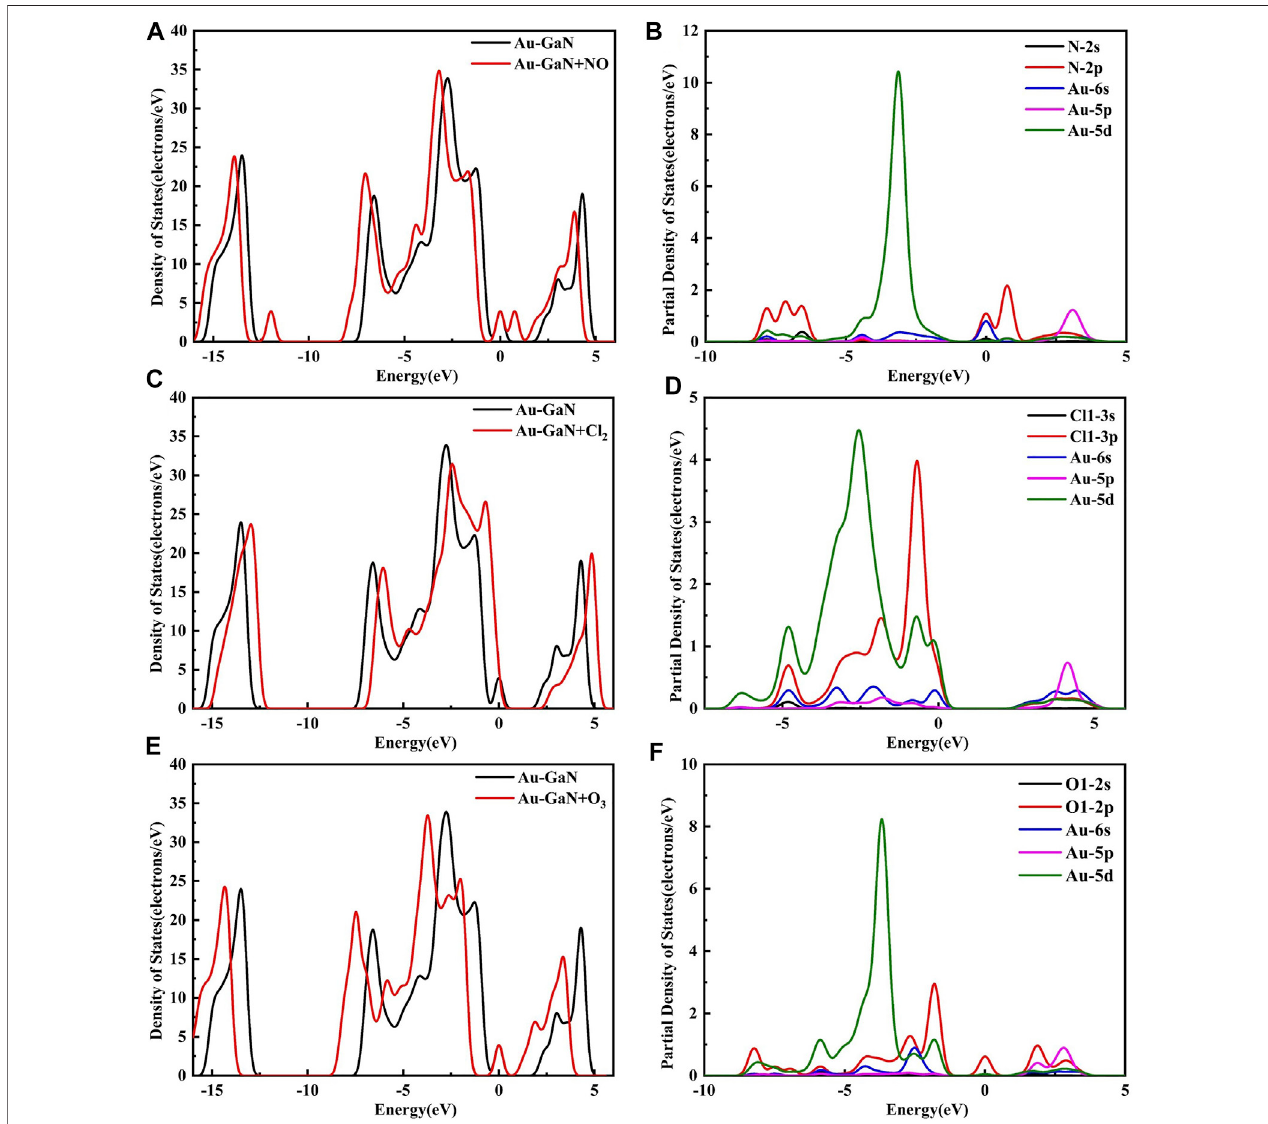
FIGURE 10 | DOS for (A) NO, (C) Cl 2 , and (E) O 3 on the Au – GaN surface and PDOS for (B) NO, (D) Cl 2 , and (F) O 3 on the Au – GaN surface.